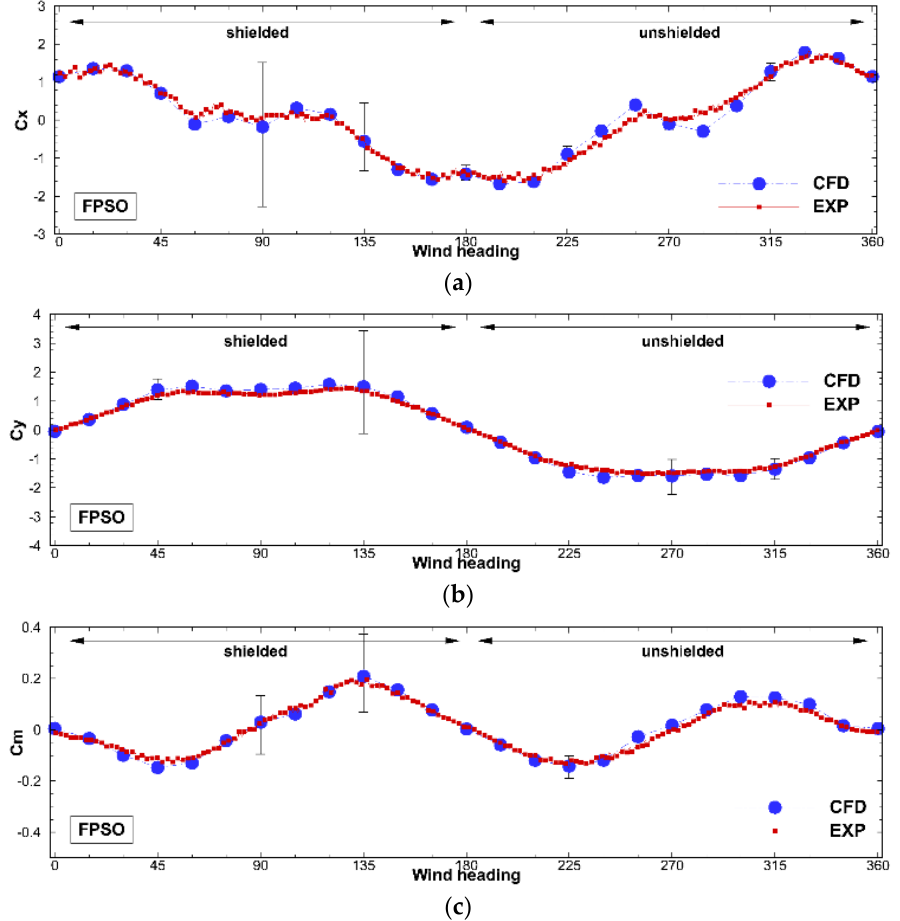
Figure 17. Comparison of aerodynamic coefficients for the FPSO in the side-by-side configuration